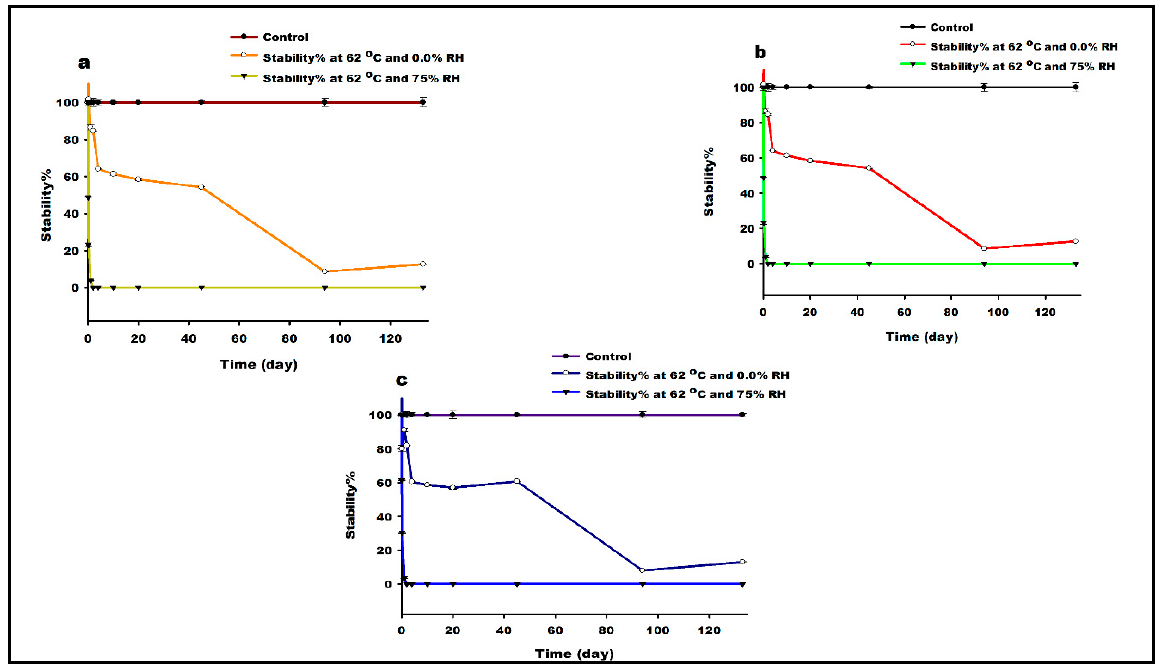
Figure 11. Thermal degradation profile of stored Lactomorphin powder under dry and wet heat conditions, followed by reconstitution with water to achieve concentration ( a ). 100 μ g/mL; ( b ). 500 μ g/mL; ( c ). 1000 μ g/mL. The control samples were stored Lactomorphin powder at − 80 °C in a desiccator (not exposed to heat or high humidity) reconstituted in water to achieve corresponding concentrations. Injected immediately after reconstitution. ( n = 3, mean ± standard deviation).